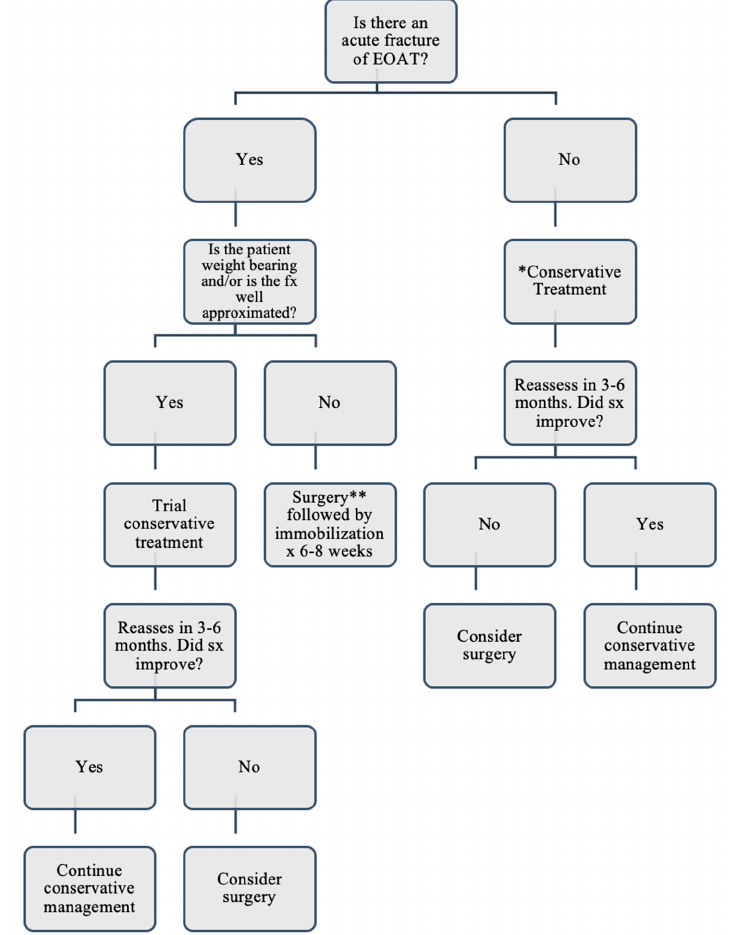
Figure 2. Management of Patients Presenting with an Extensive Ossification of the Achilles Tendon. * Conservative treatment: eccentric exercises, ice, heat, topical diclofenac or other topical agents, oral non-steroidal anti-inflammatory drugs (NSAIDs), and physical therapy. ** Surgery: various methods have achieved the same results of restoring continuity and function of the AT.